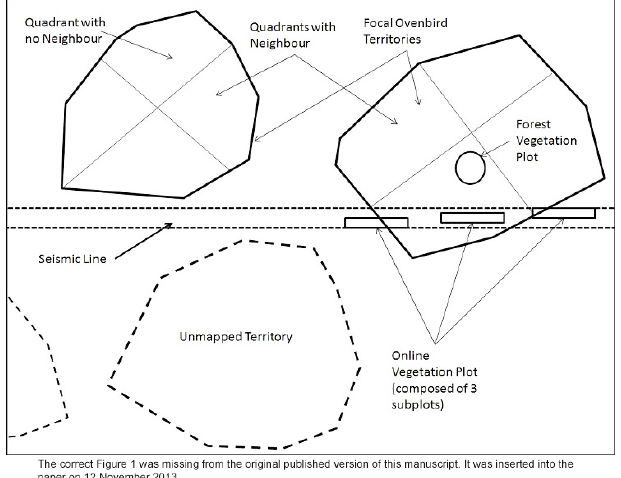
Fig. 1 . Diagram of territories showing location of vegetation plots, how quadrants are labelled, and a typical territory arragement. Each quadrant corresponds to one side of the territory. Territories were divided into quadrants using the seismic line as a reference, so that they were all oriented the same relative to the line. Seismic lines ranged from 5 to 10 m in width. Territories were 100 to 150 m in diameter, although shape varied from circular to